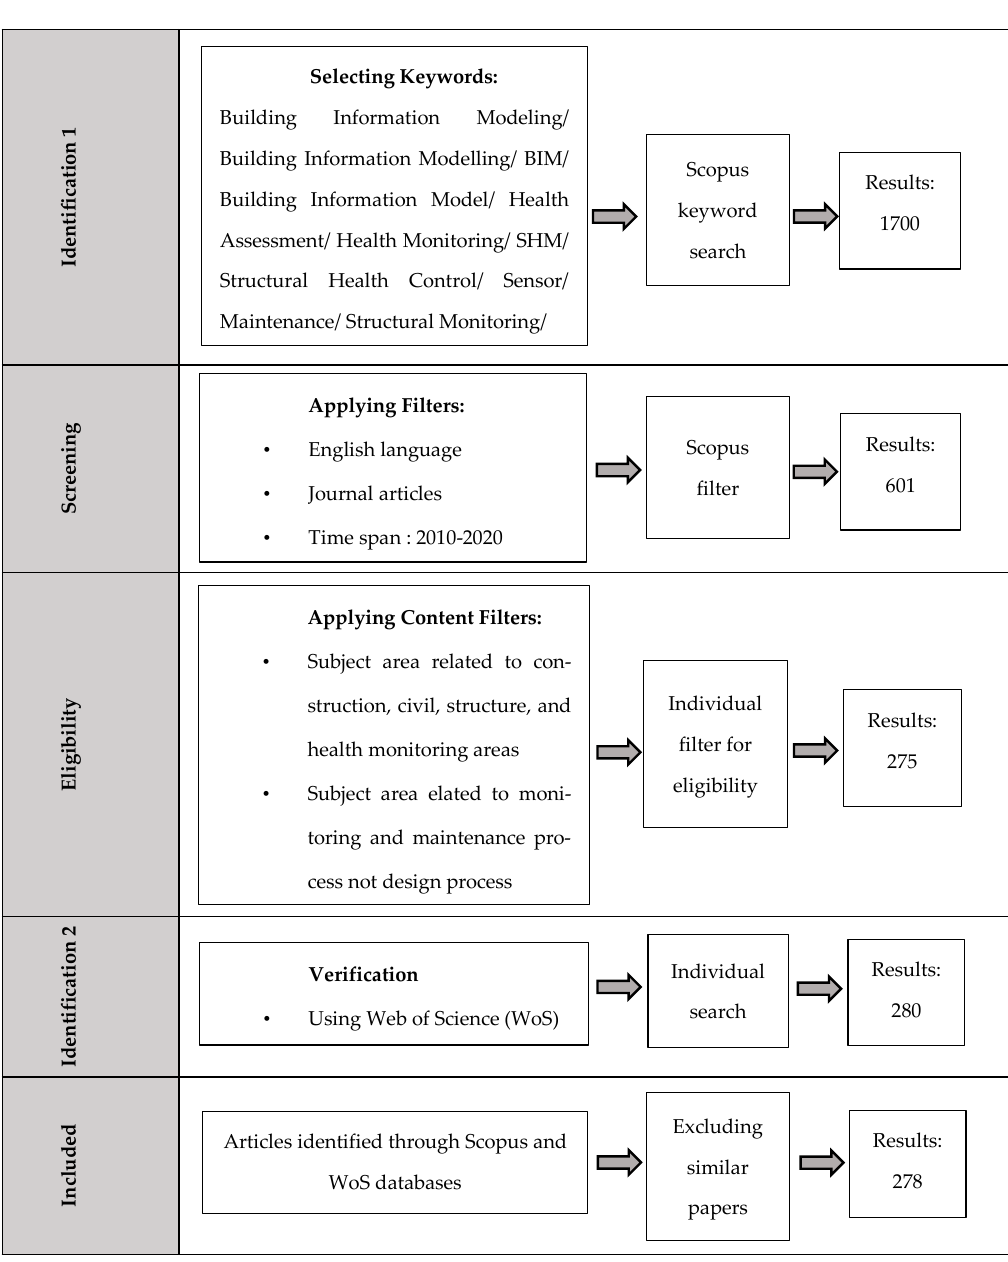
Figure 1. Methodology diagram of article selection for Building Information Modelling (BIM) in monitoring and mainte- nance.